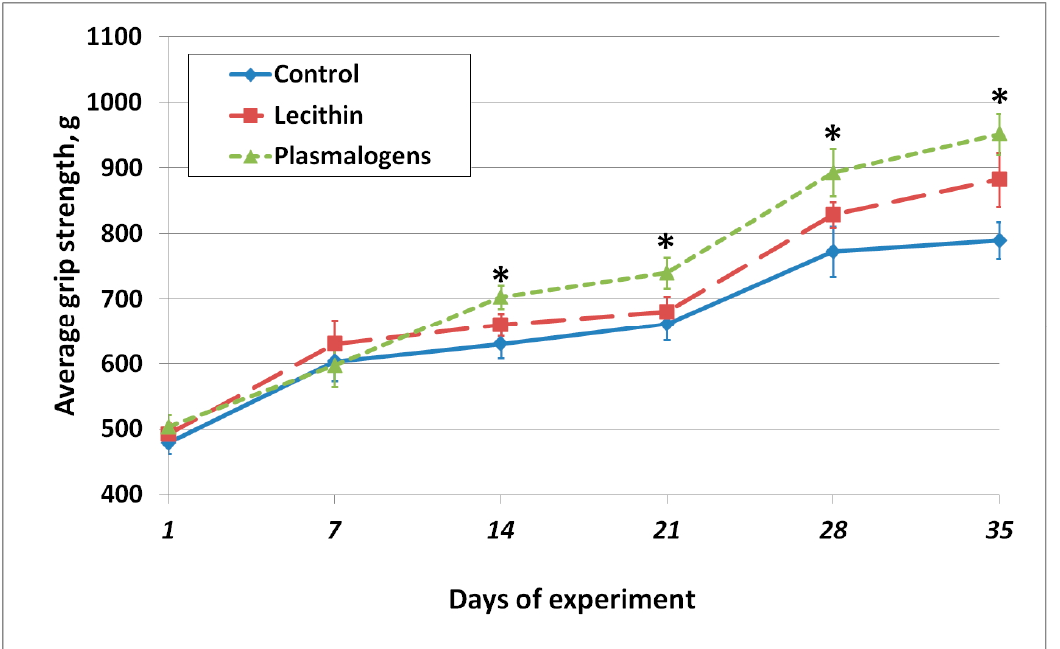
Figure 3. Dynamics of average grip strength values. Values are mean ± SEM of 15 rats per group * one-way ANOVA p < 0.05 versus Control.